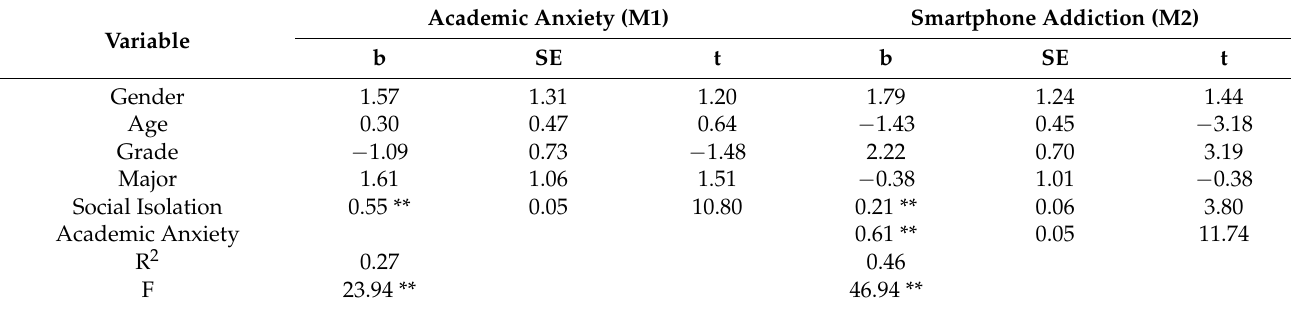
Table 3. Analysis of the mediating role of academic